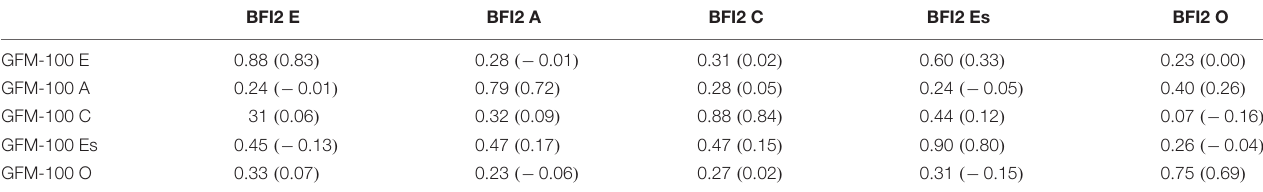
TABLE 5 | Convergent validity: univariate correlations between the factor scales of GFM English and BFI-2, and partial correlations with control for evaluative